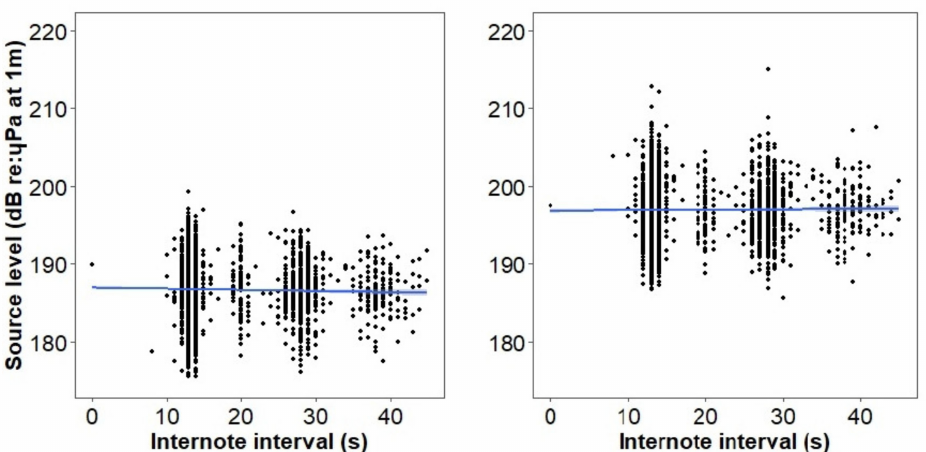
Figure 8. Estimated source levels from 20 Hz fin whale notes manually detected in the H-channel ( left ) and the Z-channel ( right ) from the OBS off southwest Portugal against inter-note interval. The blue line represents a linear regression fitted to the data (black